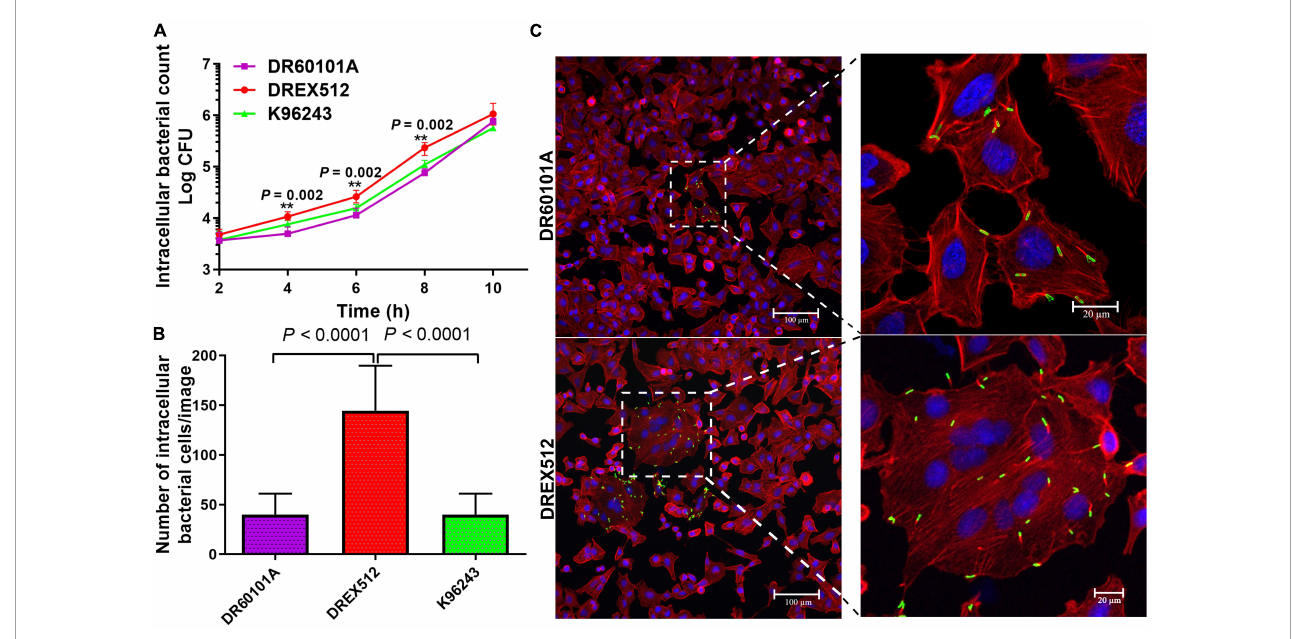
FIGURE3 Intracellular survival and immunostaining of A549 cells infected with primary DR60101A and persistent DREX512 strains from P17 and reference Burkholderia pseudomallei K96243. (A) Intracellular survival at 2, 4, 6, 8, and 10 h post-infection by plate counting. (B) Number of bacterial cells per image at 8 h post-infection by confocal microscopy. (C) Visualization of infected staining A549 cells by confocal microscopy. Bacteria were stained in green, cytoplasm in red, and DNA in